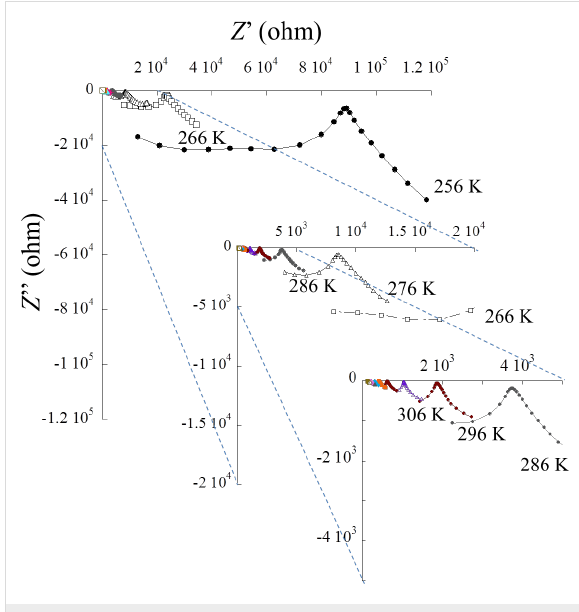
Figure 12: Nyquist curve Z ”( ω ) vs Z ’( ω ) for TBA20IL with zoom-ins to the central areas of the plot vs